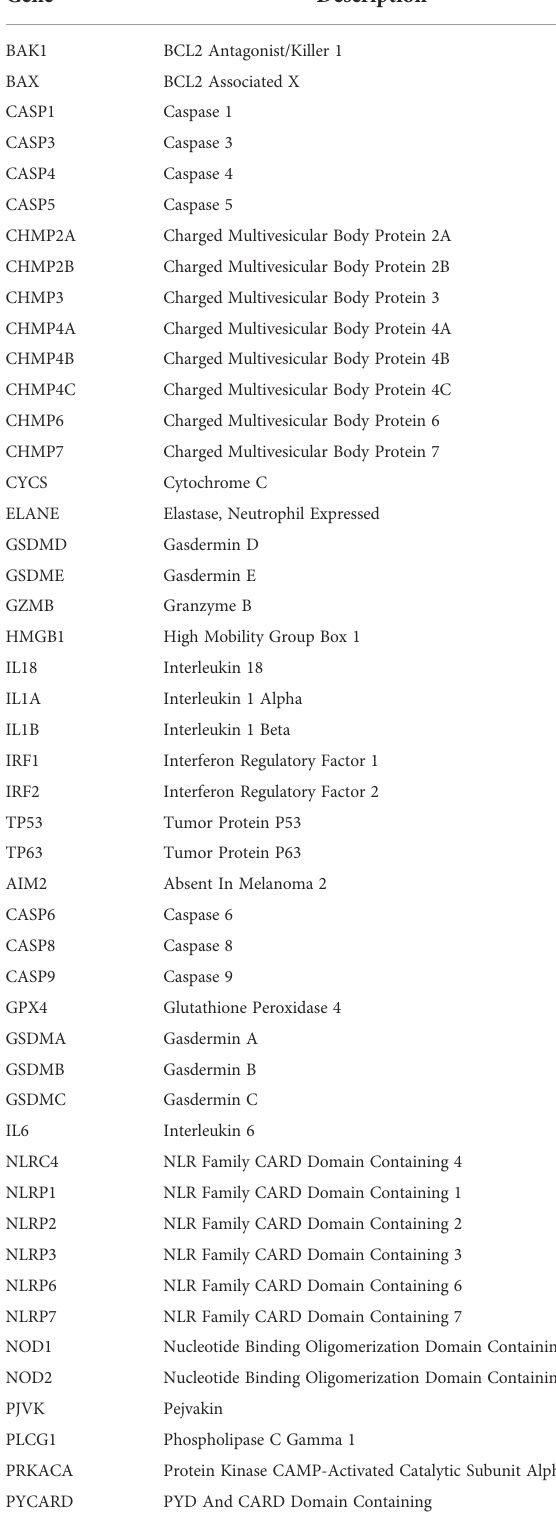
TABLE 1 Pyroptosis-related Gene Signature with the Prognosis of Hepato cellular